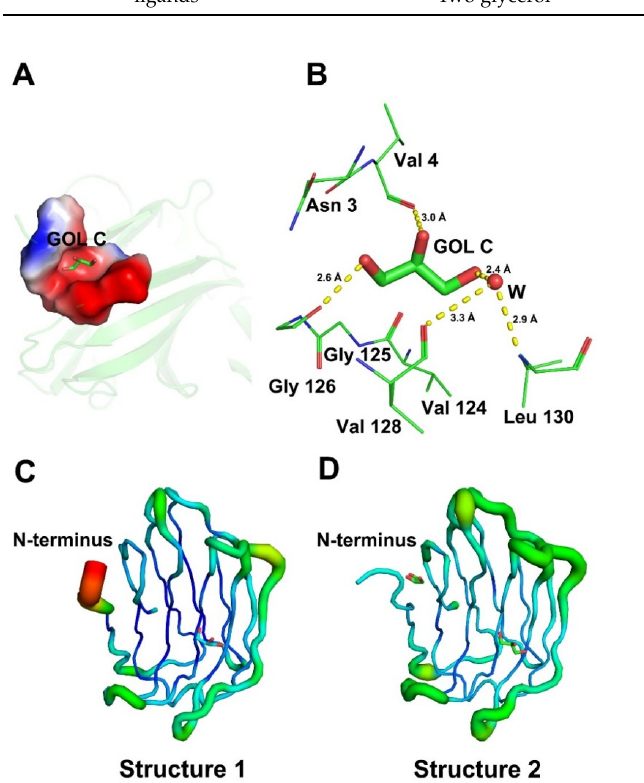
Figure 4. Glycerol ‐ binding sites of Gal ‐ 7. ( A ) The region of the N ‐ terminal (Asn 3 ‐ Val 4) and loop connecting strands S2 and F1(Val 124 ‐ Leu 130) formed a GOL C ‐ binding pocket. ( B ) GOL C in its binding pocket is stabilized by Val 4, Gly 126 and a nearby water molecule through hydrogen bonds (colored yellow). Water molecule is labeled by deep salmon. ( C ) B ‐ factor analysis of monomer A of structure 1. ( D ) B ‐ factor analysis of monomer A of structure 2.